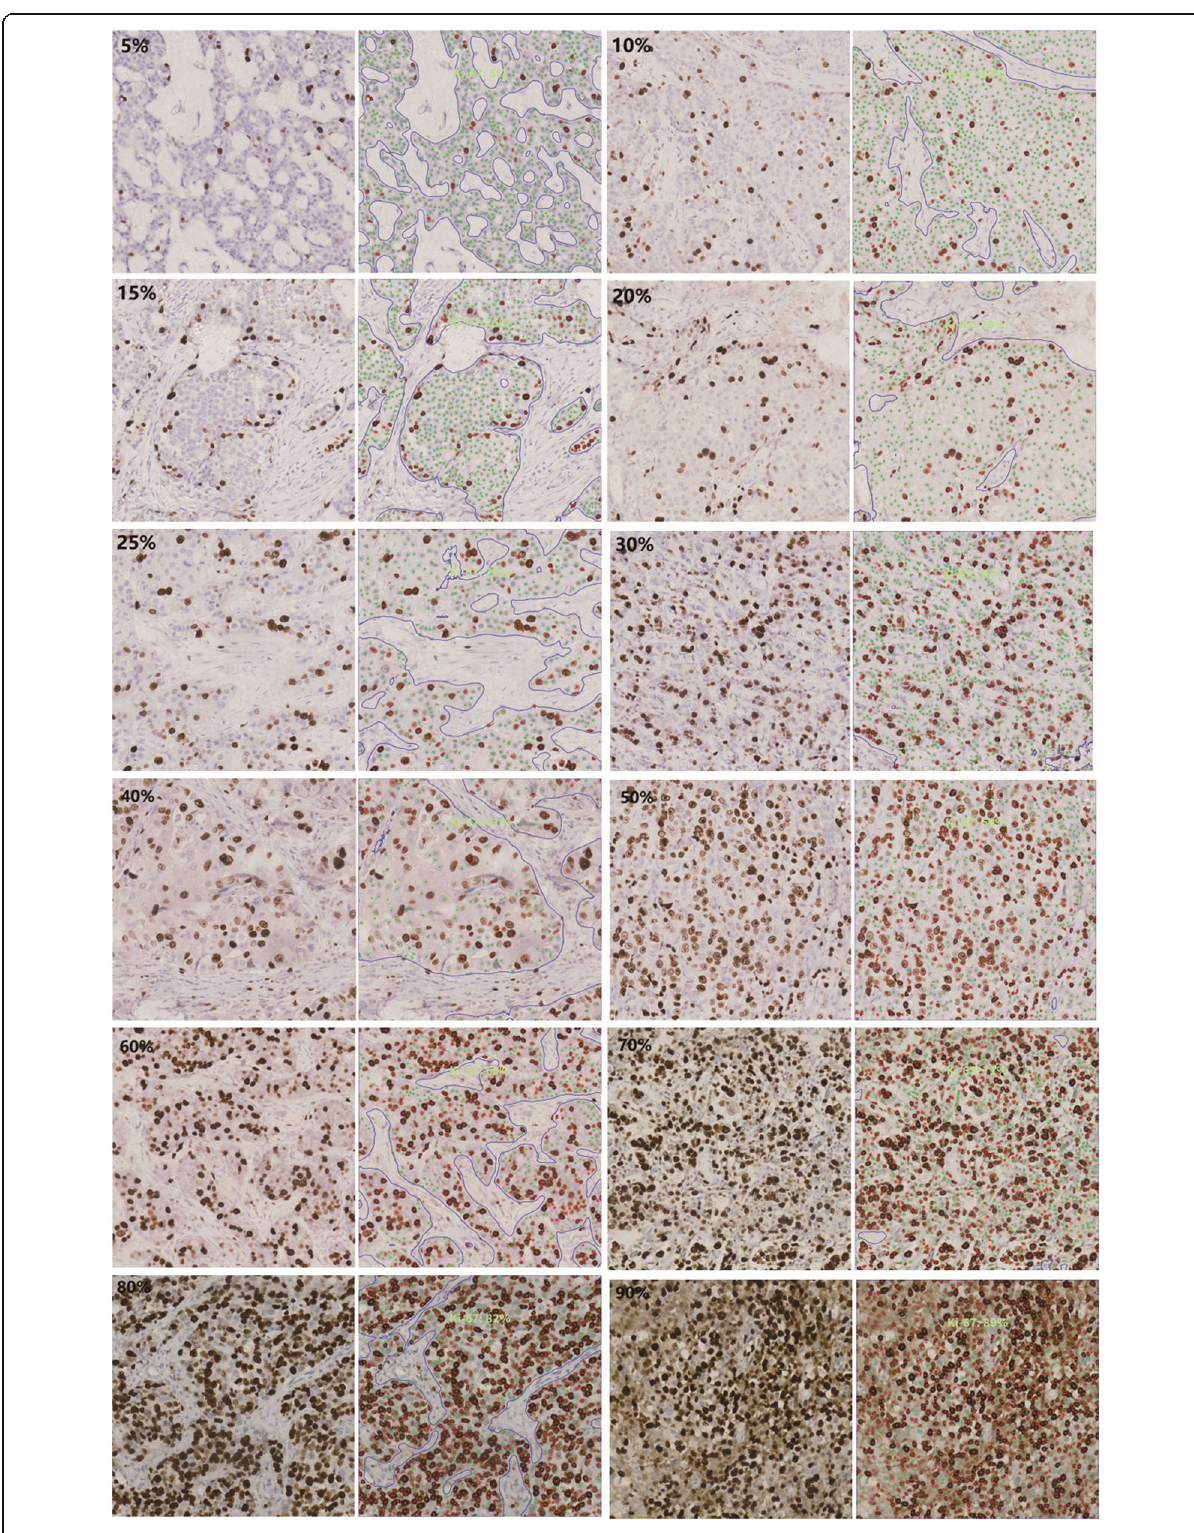
Fig. 1 Breast cancer Ki-67 standard comparison card (5, 10, 15, 20, 25, 30, 40, 50, 60, 70, 80,